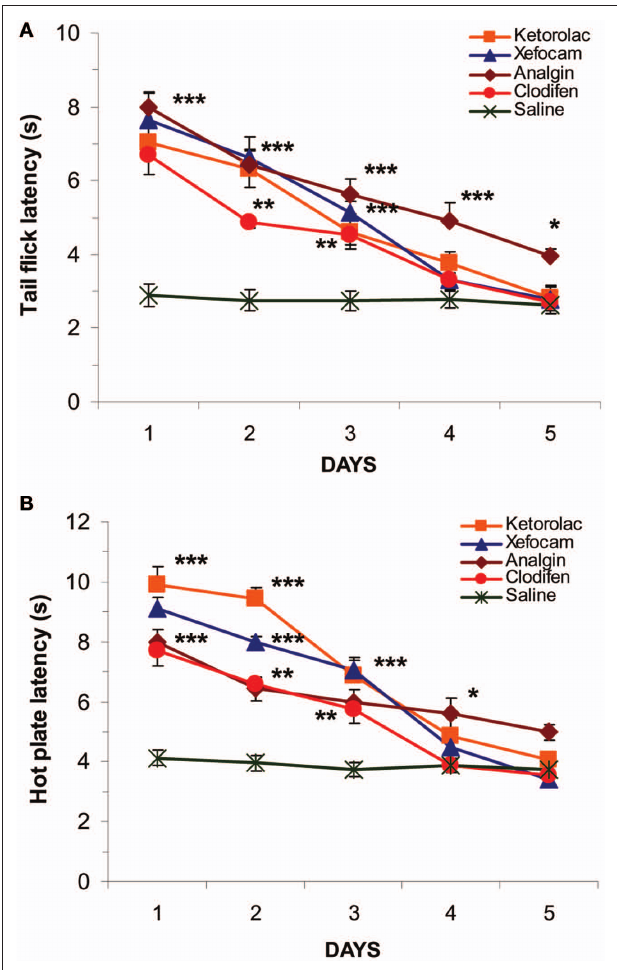
Figure 2 | Microinjections of NSAiDs into the NrM for five consecutive days result in progressively decrease in TF (A) and HP (B) latencies as compared to vehicle saline control (* P < 0.05, ** P < 0.01, *** P < 0.001).